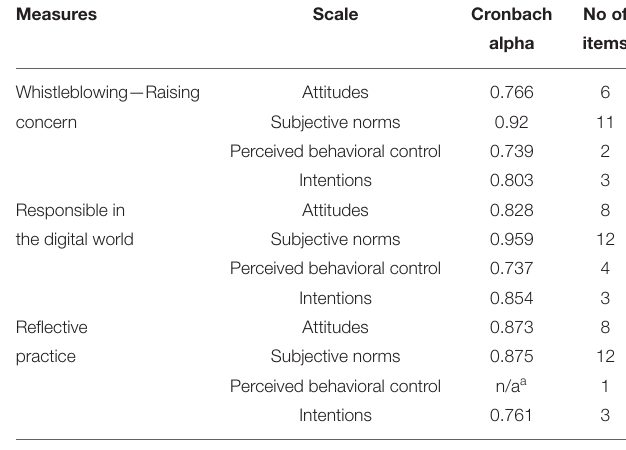
TABLE 3 | Questionnaire reliability measure analysis in post-work-shop survey ( n = 59).